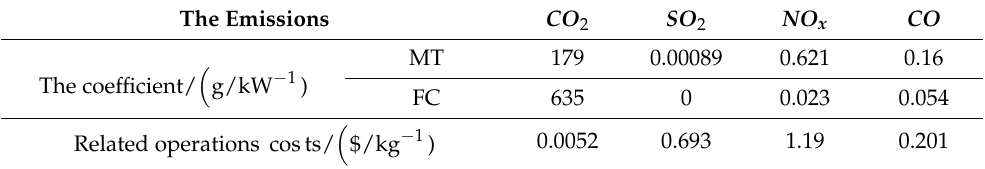
Table 5. The emission-related operations cost of pollution remediation and emission coefficients. The Emissions CO 2 SO 2 NO x